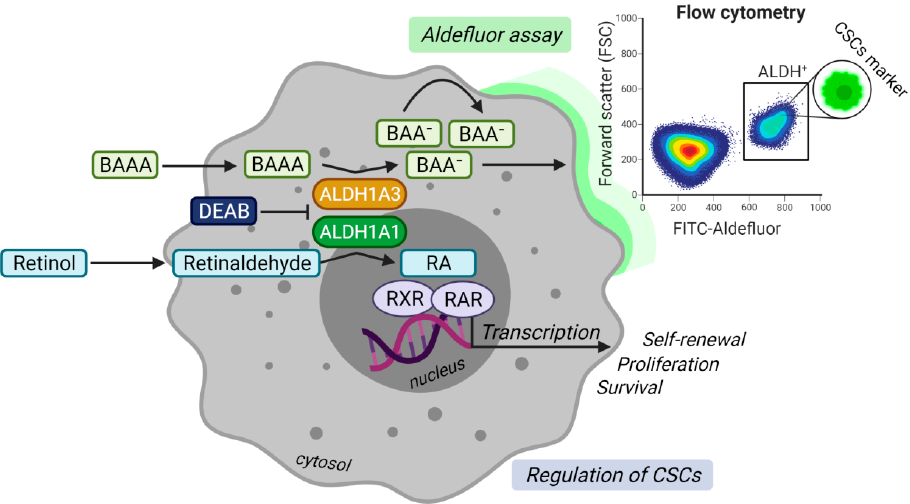
Figure 1. Model illustrating the enzymatic function of aldehyde dehydrogenases (ALDH)1A1 and ALDH1A3 proteins in ALDEFLUOR assay and the regulation of cancer stem cells (CSCs) through retinoic acid (RA) signaling. In the upper panel, prostate cancer cells expressing ALDH1A1 and ALDH1A3 convert uncharged fluorescent ALDH substrate BODIPY-aminoacetaldehyde (BAAA) into negatively charged BODIPY-aminoacetate (BAA − ). BAA − is retained inside the cell, making the subset of ALDH+ cells highly fluorescent. Diethylaminobenzaldehyde (DEAB), a specific ALDH inhibitor, prevents the cells from becoming fluorescent and is used as a negative control. The fluorescence can be measured by flow cytometry. The lower panel demonstrates that ALDH1A1 and ALDH1A3 proteins regulate CSCs via the production of retinoic acid (RA) from retinaldehyde (also known as retinal). RA binds to heterodimers formed by retinoid x receptor (RXR) and retinoic acid receptor (RAR) in the nucleus. Activation of the receptors complex stimulates transcription of the target genes regulating self-renewal, proliferation, and survival. Created with BioRender.